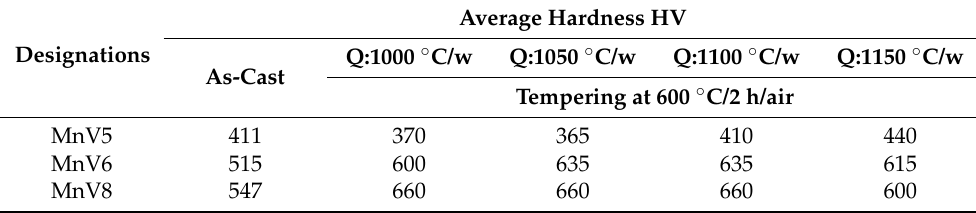
Figure 4. As-cast microstructure produced in test castings containing: ( a ) 5.5% V; ( b ) 6.3% V; and ( c ) 8.1% V, etching with nital. Table 3. Changes in hardness values as a function of vanadium content and temperature of quenching and